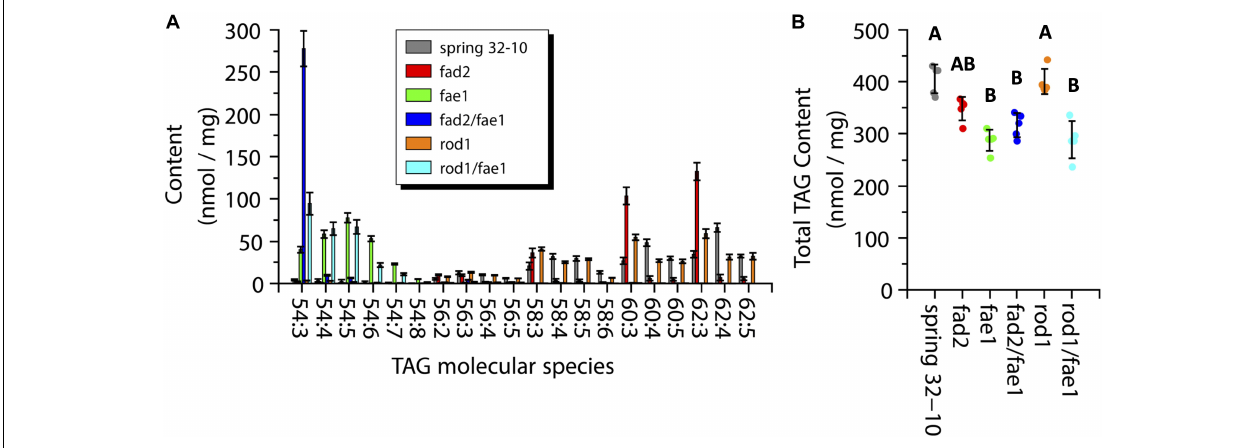
FIGURE 7 | Measurements of triacylglycerol (TAG) molecular species composition (A) and total content (B) within wild-type Spring 32-10 (dark gray) and CRISPR/Cas9 mutant T. arvense seeds fad2 (red), fae1 (green), fad2 fae1 (dark blue), rod1 (orange), and rod1 fae1 (light blue). Error bars represent standard deviations of the means. ( n = 5, ± SD, one-way ANOVA; Tukey test, p < 0.01).